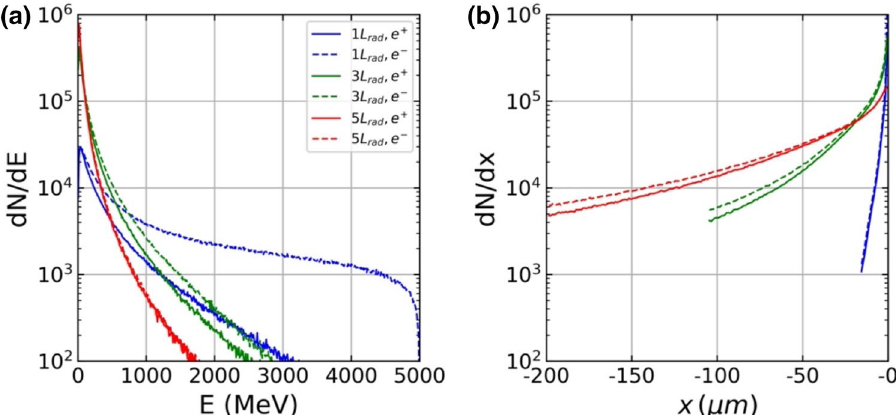
Figure 6. ( a ) Energy spectra of electrons (dashed lines) and positrons (solid lines) inside positron beam volume for different lead converter thicknesses. ( b ) Longitudinal distributions of electrons and